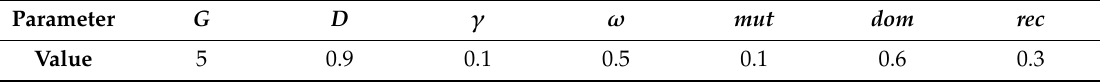
Table 2. Parameter to execute Genetic Algorithm for solving